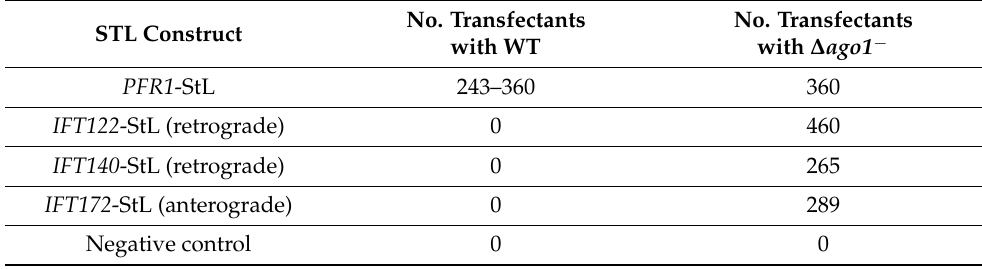
Table 1. RNAi of several IFT genes in Leishmania braziliensis is lethal. No. Transfectants STL Construct with